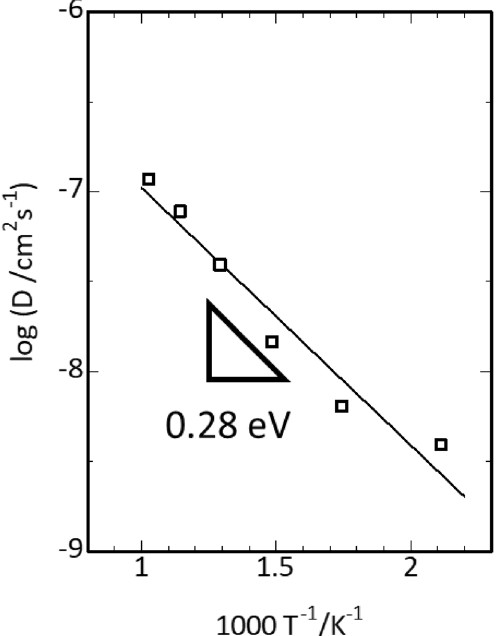
Figure 6. Arrhenius plot for the diffusion coefficient of Model 4 (4.5 mol% excess Li ions) by force field molecular dynamics (FFMD) calculations performed at 473–973 K. The activation energy evaluated from the straight-line slope is 0.28